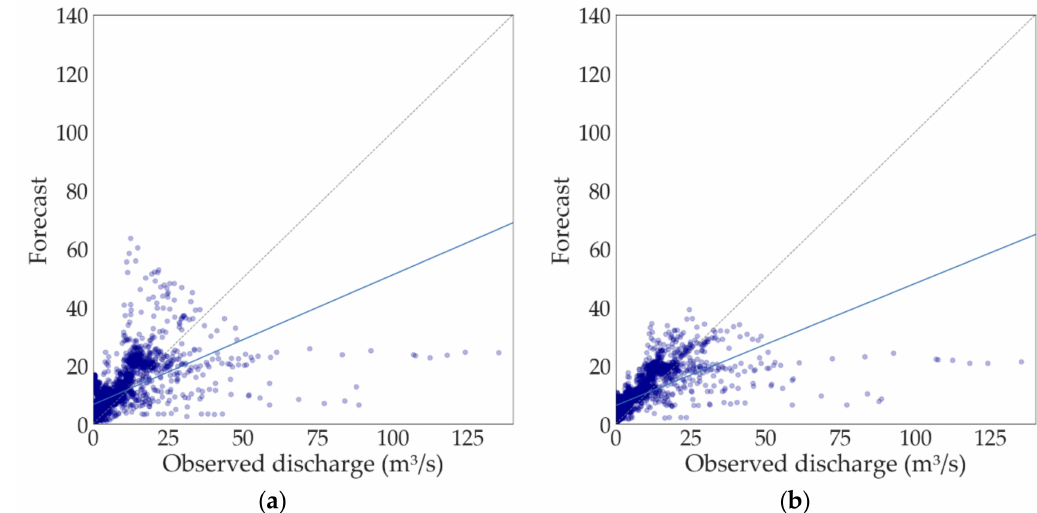
Figure 7. Observed vs. forecast runoff by using the test dataset (12 h lead-time). ( a ) Default hyperparameters; ( b ) optimized